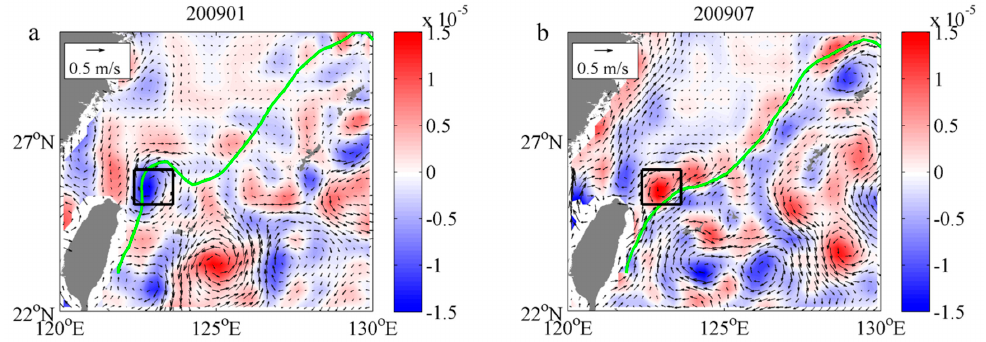
Figure 16. The geostrophic velocity anomaly (vectors) and relative vorticity (color shading) during January ( a ) and July ( b ), 2009. Black squares delineates the region where the interaction between the eddies and Kuroshio often occurs on the northeast of Taiwan Island.